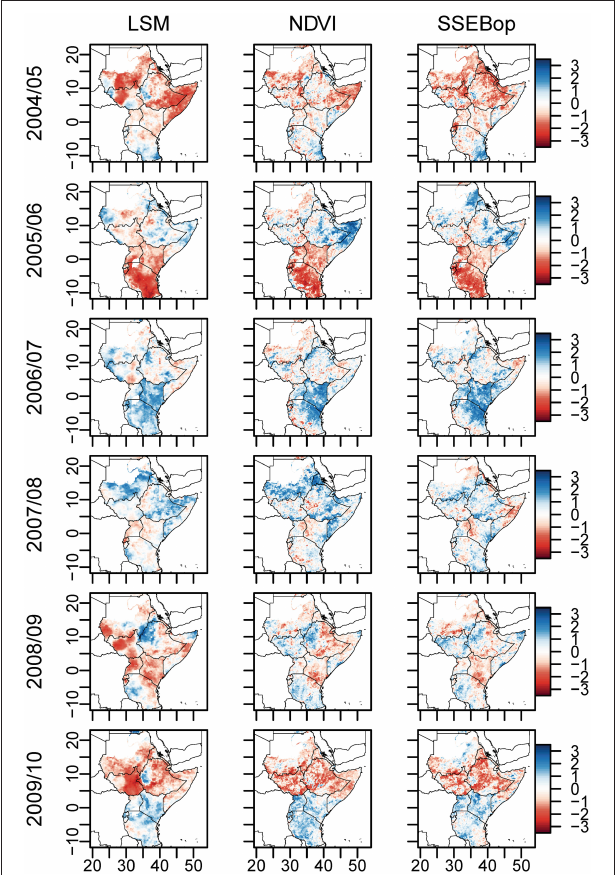
FIGURE 3 | Standardized anomaly composites of LSM ET, NDVI, and SSEBop ET over the wetter half of the year for the period 2004–2010. May–October for